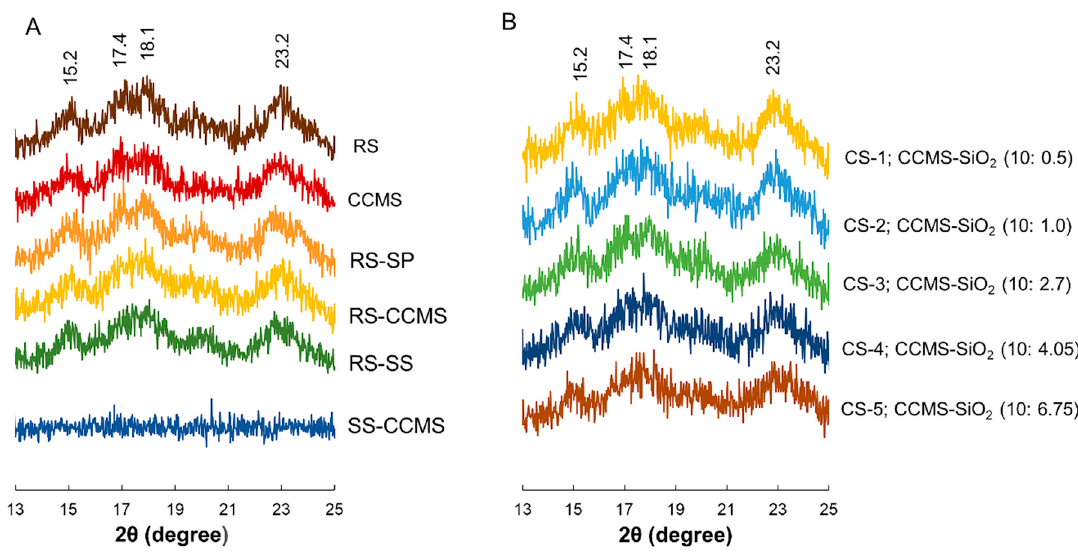
Figure 3. X - ray diffraction pattern of ( A) control samples, and ( B ) co-processed rice starch - based Figure 3. X-ray di ff raction pattern of ( A ) control samples, and ( B ) co-processed rice starch-based samples (CSs) with 10% CCMS and different SiO 2 levels (0.5%–6.75%). samples (CSs) with 10% CCMS and di ff erent SiO 2 levels